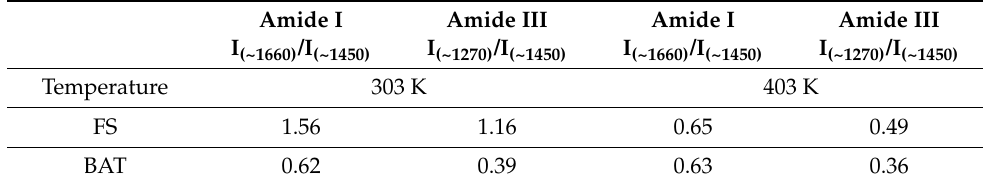
Table 2. Raman intensity ratios of amide I and amide III bands to Raman intensity of CH 2 band for FS and BAT